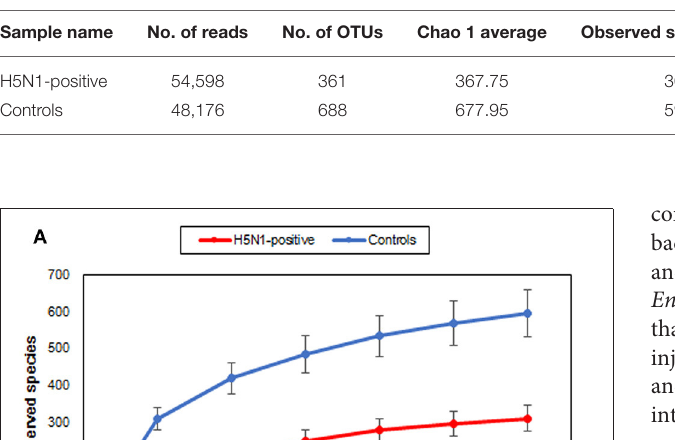
TABLE 1 | Comparison of phylotype coverage and diversity index at 97% similarity.